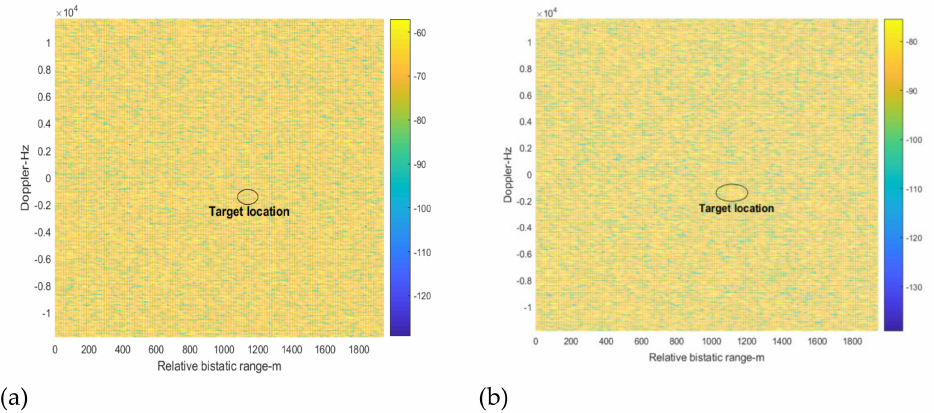
Figure 10. The cross-correlation results after interference suppression by the traditional method, ( a ) spatial-time ( b )